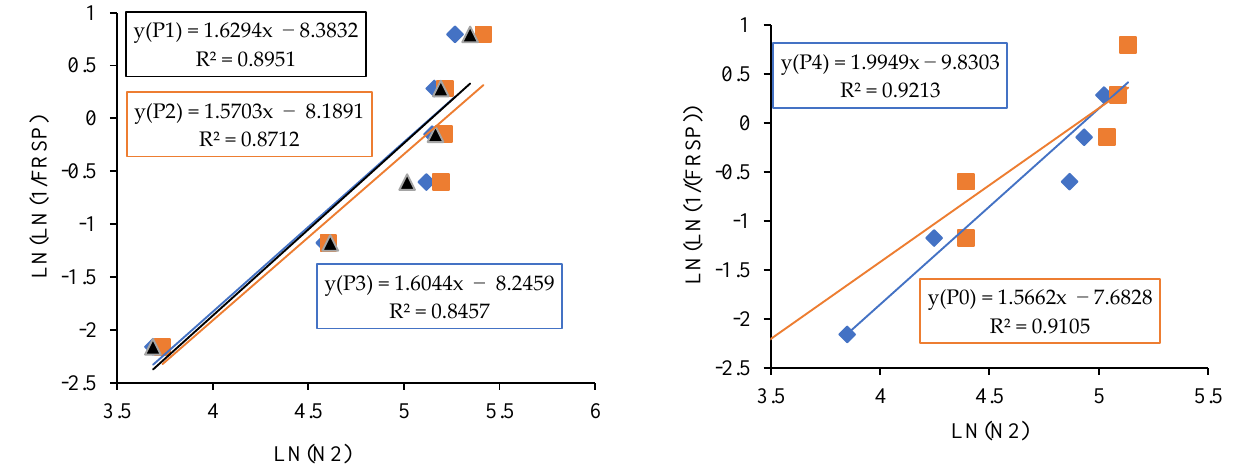
Figure 20. Weibull distribution for P0, P1, P2, P3 and P4 mixes at initial crack on 7 days. Figure 19. Weibull distribution for P0, P1, P2, P3 and P4 mixes at failure on 28 days. Figure 17. Weibull distribution for P0, P1, P2, P3 and P4 mixes at failure on 28 days.